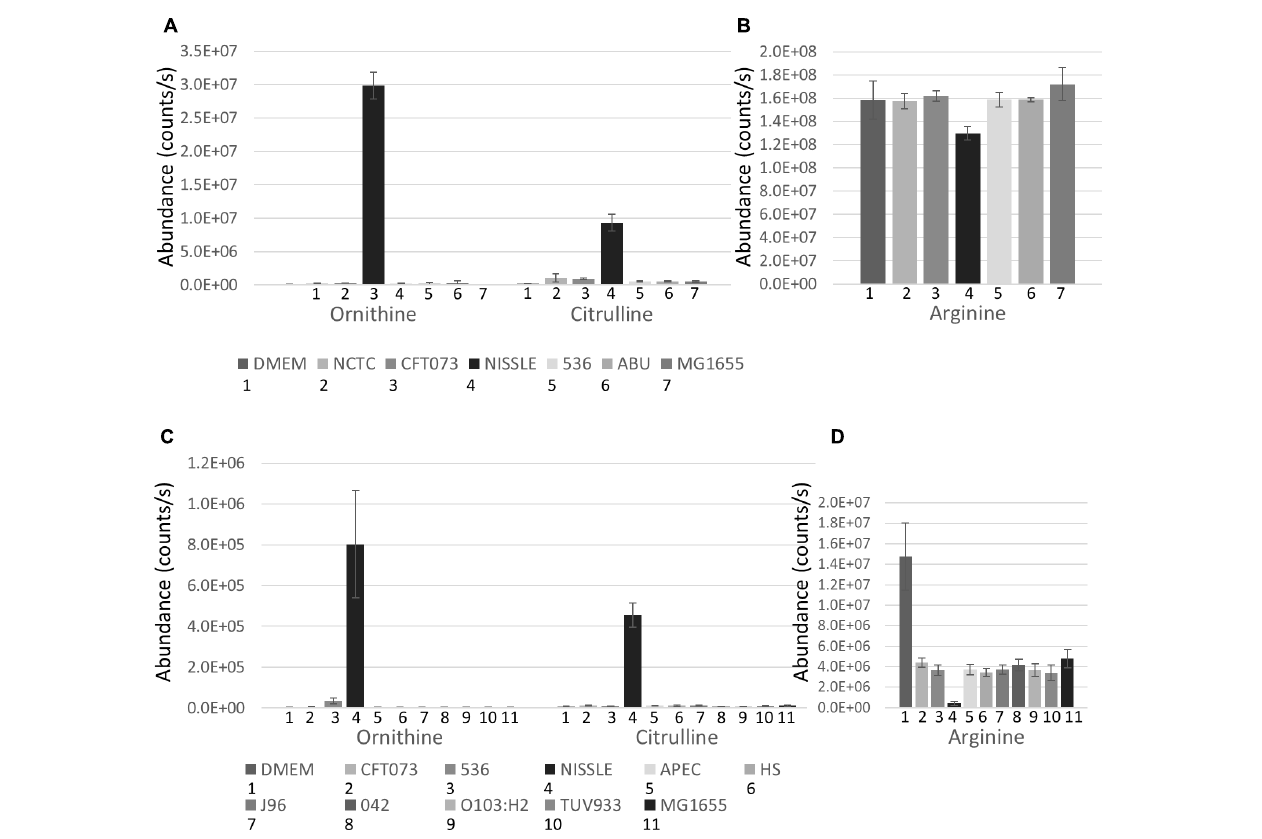
FIGURE 2 | B2 focussed extracellular abundance of Arginine biosynthesis metabolites: (A) Average levels (counts/s) of Ornithine and Citrulline in DMEM medium and supernatant of 6 E. coli strains including 5 from phylogroup B2 and the laboratory reference strain MG1655 determined from 5 replicates. Nissle releases substantially higher levels of Ornithine and Citrulline into its environment than the other E. coli strains measured. (B) Level (counts/s) of Arginine in DMEM media and supernatant of the 6 E. coli strains. Nissle was found to deplete more Arginine from the media than the other strains measured. Extracellular abundance of Arginine biosynthesis metabolites identified in Study 1: (C) Average levels (counts/s) of Ornithine and Citrulline in DMEM medium and supernatant of 10 E. coli strains including 5 from phylogroup B2 and 5 from other phylogroups. Nissle secretes both Ornithine and Citrulline in much higher quantities than the other 9 strains measured. (D) Average levels (counts/s) of Arginine in DMEM media and supernatant of the 10 E. coli strains. Nissle was found to deplete more Arginine from the media than the other 9 strains analyzed.